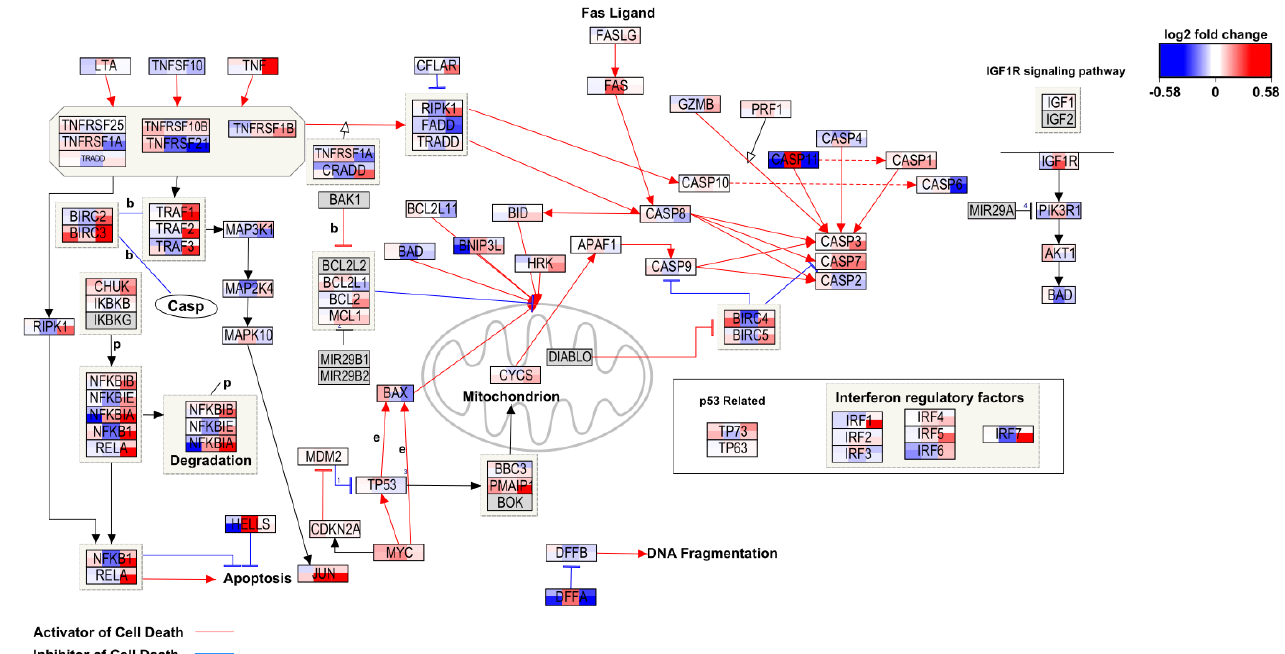
Figure A2. Visualization of log 2 fold change on the Apoptosis pathway (wikipathways:WP254) for all six conditions. Cellular models are depicted from left to right as Caco-2/HT29-MTX, SAE, and THP1. The top row depicts the low concentrations whereas the bottom row depicts the high concentrations. Color gradient for differential gene expression after exposure goes from blue (downregulated) via white (not changed) to red